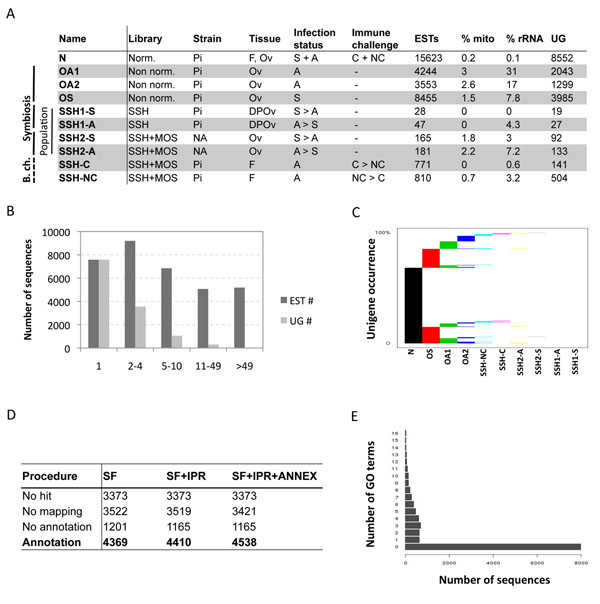
Characteristics of the EST libraries A. Summary of the different EST libraries from Asobara tabida, used to build a transcriptomic map, but also to address the question of the effect of symbiosis and bacterial challenge (b. ch.) on host gene expression. cDNA libraries were sequenced with or without normalization (Norm. or Non norm., respectively). Suppression Subtractive Hybridizations (SSHs) were performed with or without the Mirror Orientation Selection procedure (MOS). The influence of ovarian phenotype was addressed using two different populations known to exhibit extreme phenotypes after Wolbachia removal: females from the Pi3 strain (Pierrefeu, France) do not produce any eggs, while females from the NA strain (Saanich, Canada) produce a few eggs that fail to develop normally. Immune challenge was performed by injecting 1.8x105 Salmonella typhimurium in aposymbiotic females, and RNA was extracted 3h, 6h and 12h after challenge. Abbreviations stand for: DPOv: Distal Part of the Ovaries (e.g. without the eggs), Ov: Ovaries, F: Females, S: Symbiotic, A: Aposymbiotic, C: immune Challenge, NC: No immune Challenge. ESTs: Expressed Sequenced Tags, mito: mitochondrial genes, rRNA: ribosomal RNA, UG: number of unigenes found after a clustering/assembly. B. Abundance classes of ESTs and Unigenes. C. Unigene occurrences among the EST libraries. The horizontal axis represents the different EST libraries. The occurrence of unigenes within the libraries is shown on the vertical axis. A horizontal reading of the graph indicates the percentage of unigenes shared by several EST libraries. D. Gene Ontology (GO) annotation results for High Scoring Pair (HSP) coverage of 0%. GO annotation was first carried out using the Score Function (SF) of the Blast2go software. The GO terms selected by the annotation step were then merged with Interproscan predictions (SF+IPR). Finally, the annex augmentation was run (SF+IPR+ANNEX). E. Annotation distribution of GO terms.